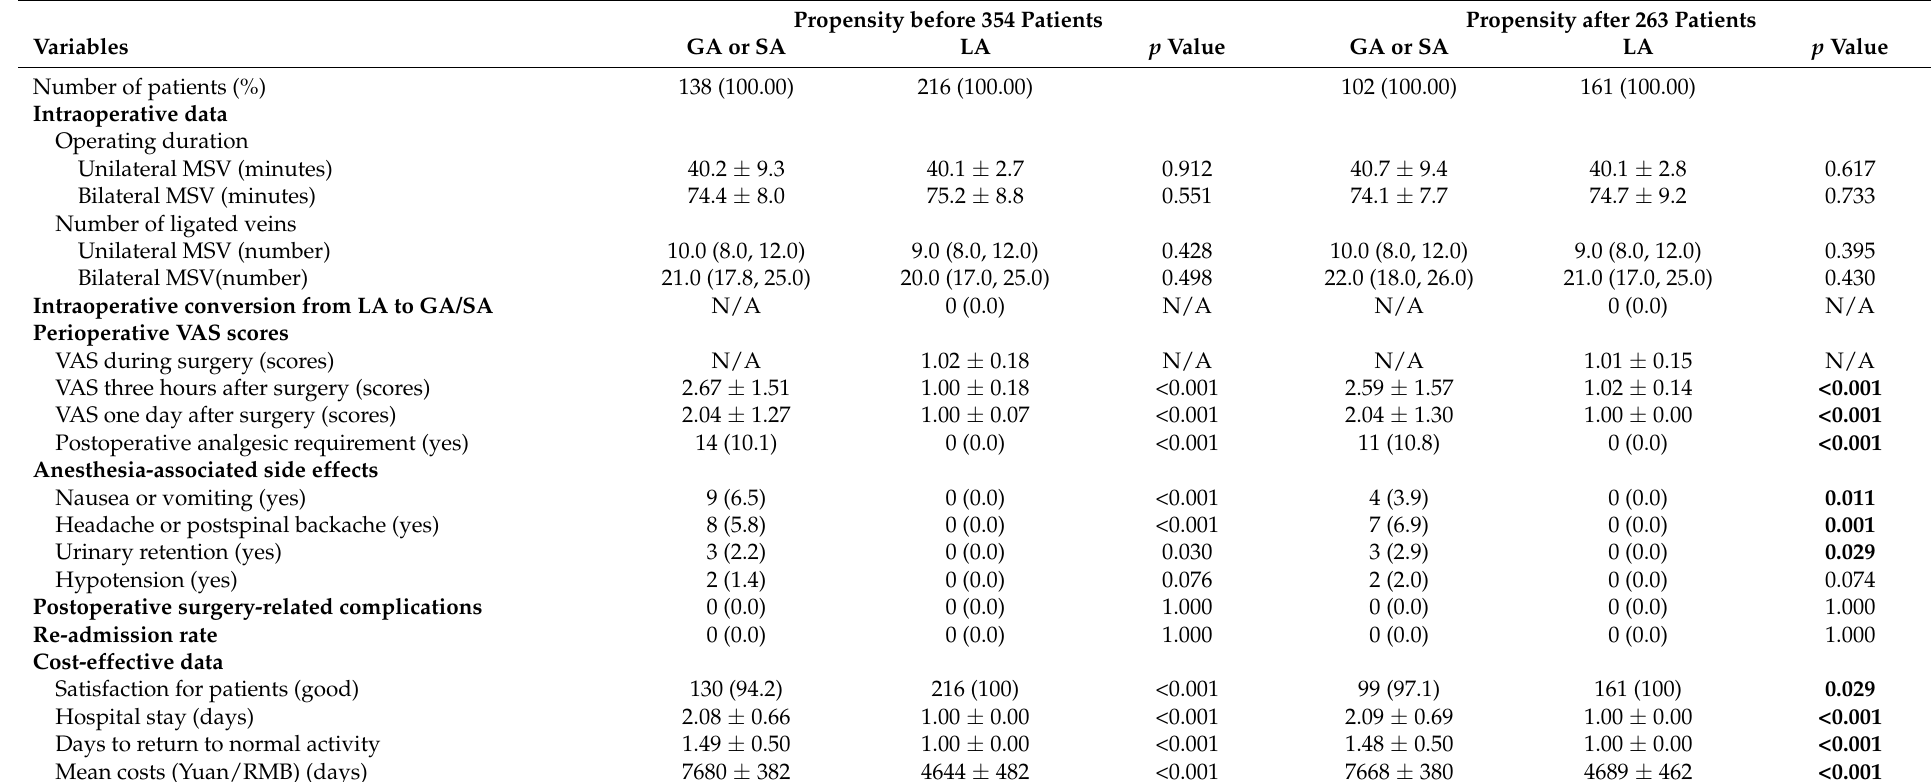
Table 2. Perioperative data in this cohort according to the anesthesia type before and after PSM. Propensity before 354 Patients Propensity after 263